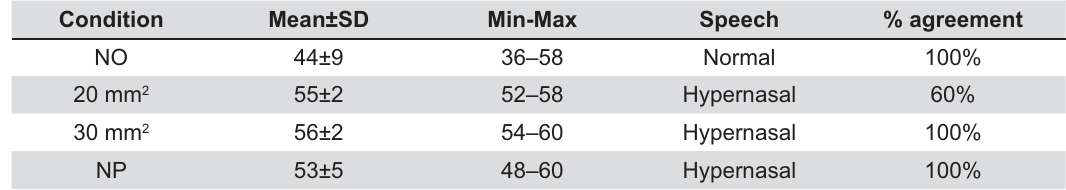
Table 1- (cid:2)(cid:3)(cid:4)(cid:5)(cid:5)(cid:6)(cid:7)(cid:8)(cid:2)(cid:9)(cid:10)(cid:2)(cid:11)(cid:12)(cid:13)(cid:14)(cid:12)(cid:15)(cid:16)(cid:2)(cid:9)(cid:10)(cid:2)(cid:17)(cid:7)(cid:18)(cid:16)(cid:18)(cid:12)(cid:19)(cid:2)(cid:16)(cid:19)(cid:4)(cid:13)(cid:8)(cid:2)(cid:23)(cid:14)(cid:19)(cid:21)(cid:2)(cid:22)(cid:9)(cid:12)(cid:13)(cid:14)(cid:19)(cid:14)(cid:9)(cid:12)(cid:16)(cid:24)(cid:2)(cid:5)(cid:18)(cid:6)(cid:12)(cid:2)(cid:12)(cid:6)(cid:16)(cid:6)(cid:25)(cid:6)(cid:12)(cid:22)(cid:18)(cid:2)(cid:16)(cid:22)(cid:9)(cid:7)(cid:18)(cid:16)(cid:2)(cid:6)(cid:12)(cid:13)(cid:2)(cid:3)(cid:19)(cid:6)(cid:12)(cid:13)(cid:6)(cid:7)(cid:13)(cid:2)(cid:26)(cid:18)(cid:20)(cid:14)(cid:6)(cid:19)(cid:14)(cid:9)(cid:12)(cid:2)(cid:27)(cid:3)(cid:26)(cid:28)(cid:24)(cid:2) minimum and maximum values of nasalance, perceptual rating of nasality and listener’s agreement during perceptual